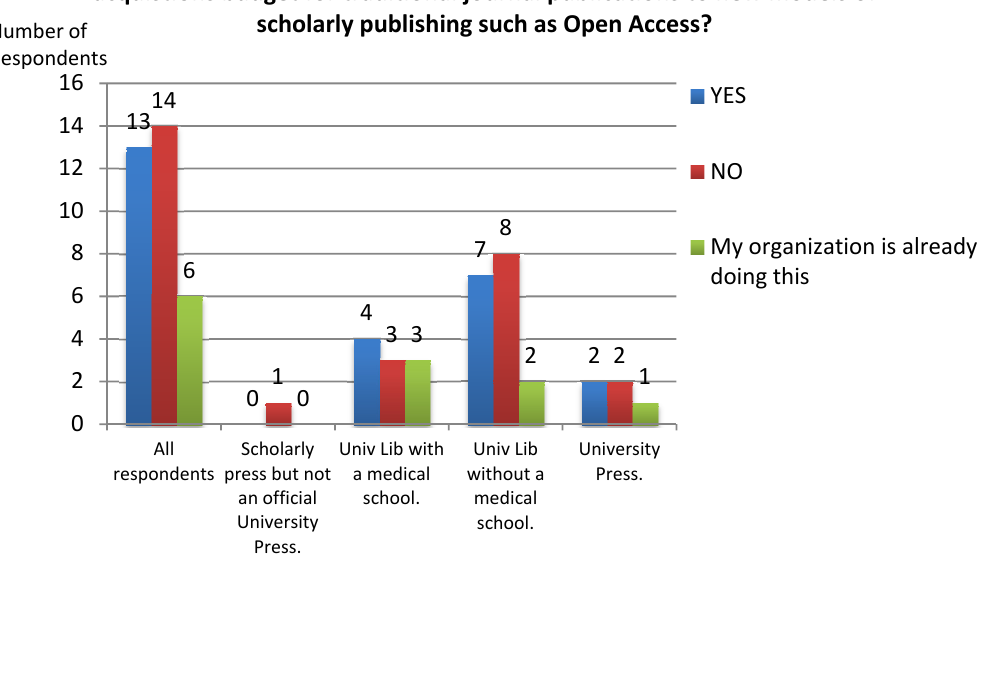
Figure 6. Reallocating traditional budgets to new models of scholarly